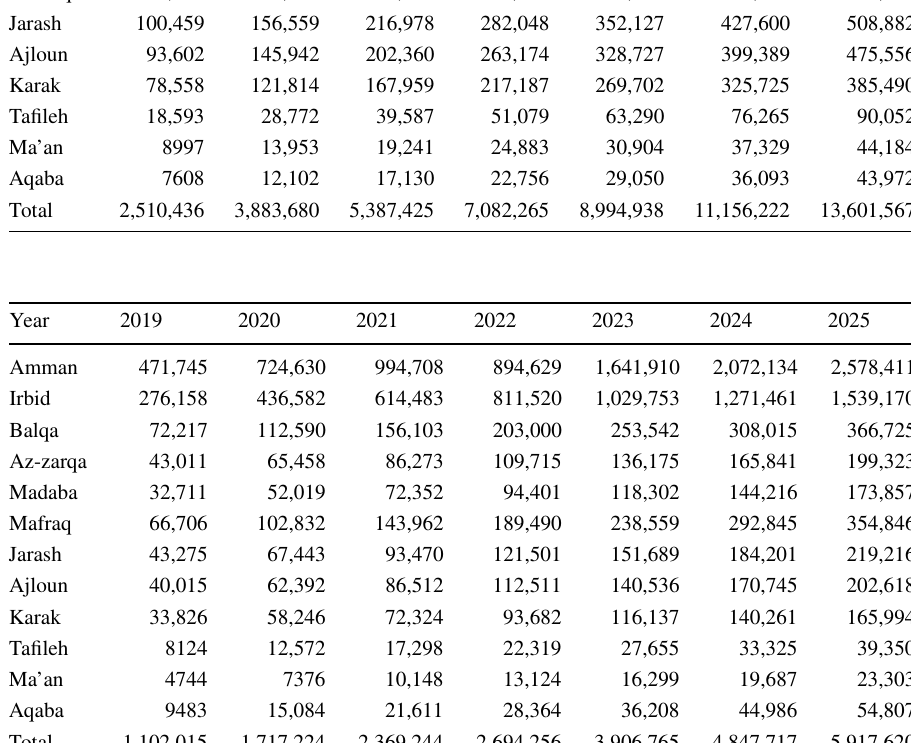
Table 3 Potential of water harvesting in scenario 1